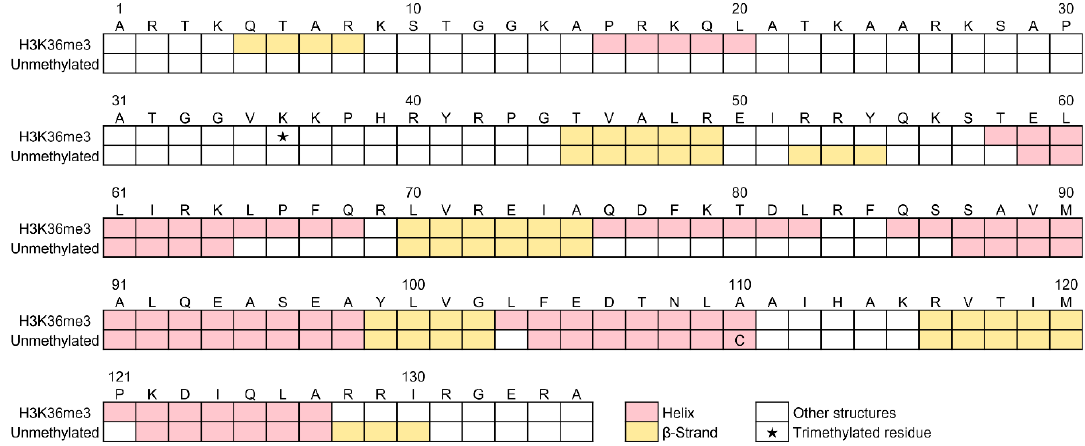
Figure 8. Sequence-based secondary structures of H3K36me3 and unmethylated H3 predicted by the VUVCD-neural network (NN) method. The data of unmethylated H3 were reproduced from a previous paper [36]. The helix, β-strand, and other structures are shown in pink, yellow, and white rectangles, respectively. The star in the rectangle shows the trimethylated residue. The 110th residue of unmethylated H3 is cysteine (C) and is different from that of H3K36me3 (alanine; A).